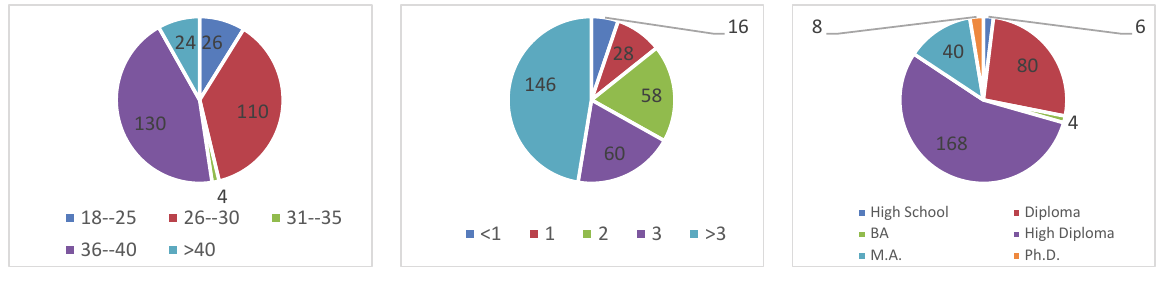
Fig. 2. Personal characteristics of the participants